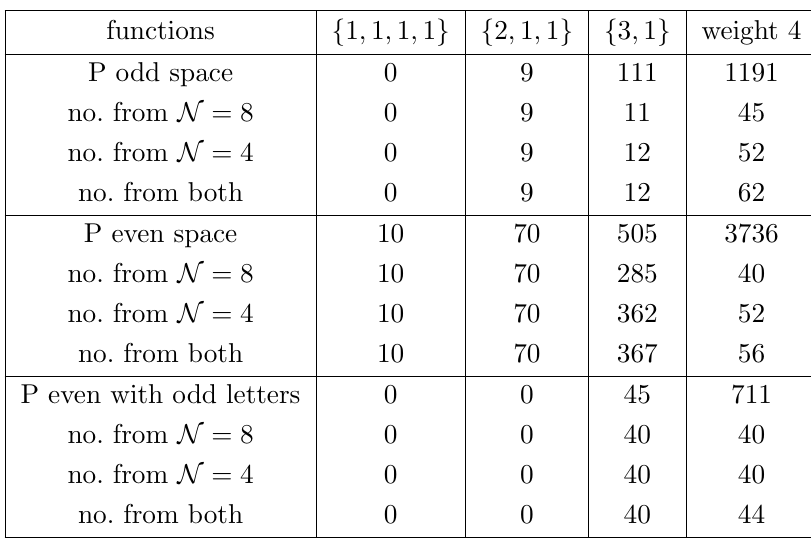
Table 1 . Table of dimensions of coproducts of the weight 4 functions for the N = 8 SUGRA and N =4 SYM twoloop (cid:12)ve-point amplitudes. By weight 2 they span the full function space with the second entry